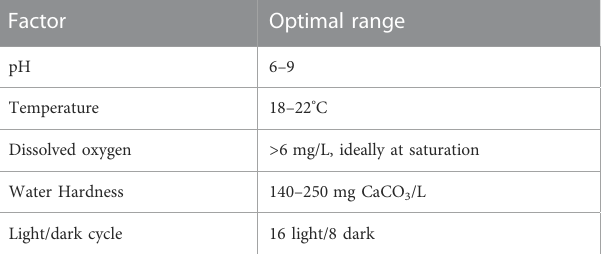
TABLE 1 Recommended conditions for optimal culture growth of Daphnia as outlined in the OECD test guideline for acute toxicity (OECD 202).